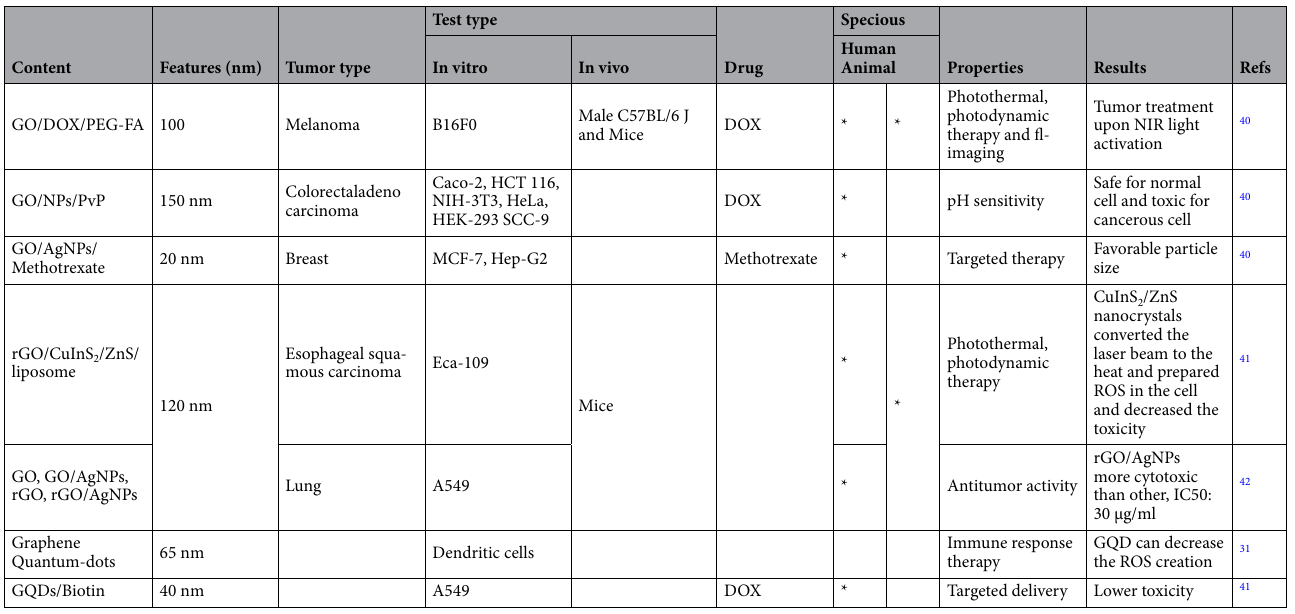
Table 1. Graphene-based nanosystem as a therapeutic